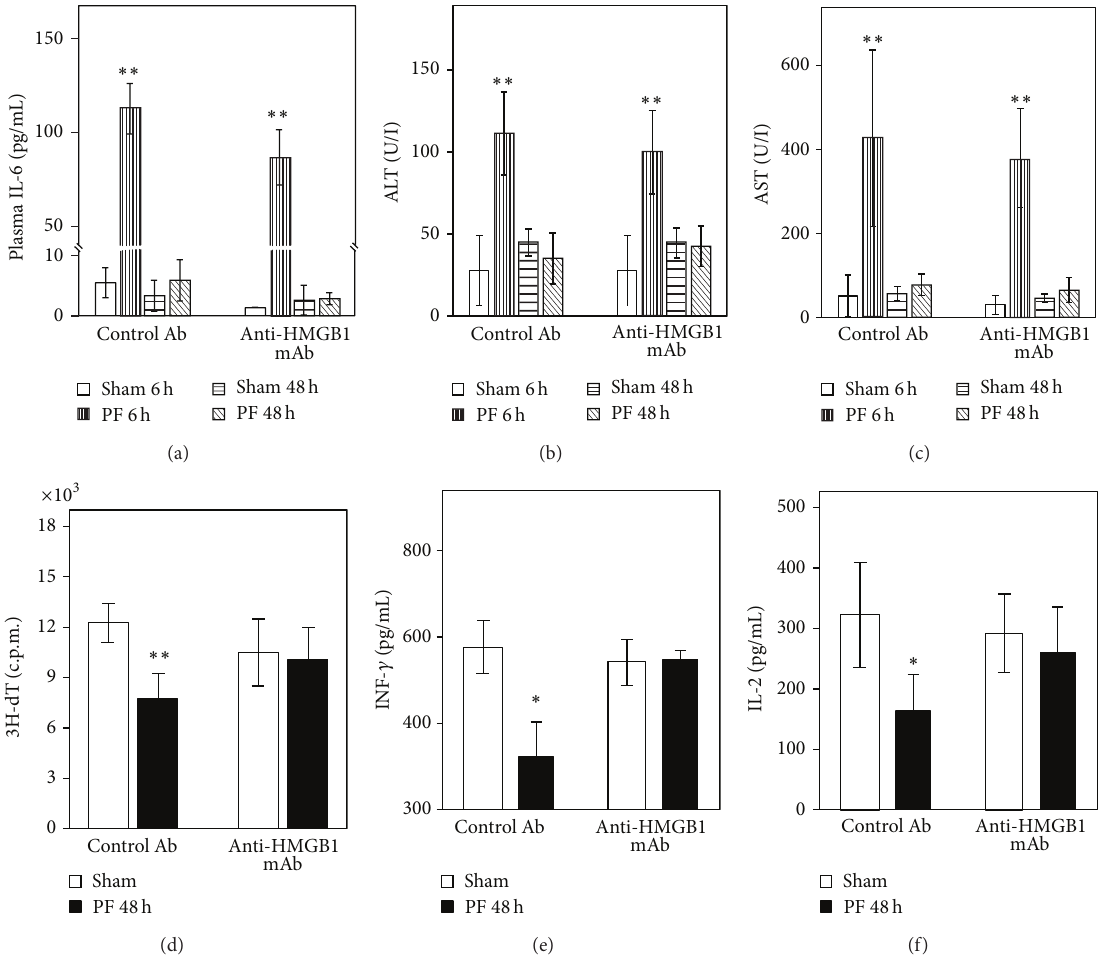
Figure3:Anti-HMGB1neutralizingmAbamelioratesattenuatedT-cellresponsesatlatetimepoints,butnottheearlyinflammatoryresponses or hepatic injury after pseudofracture (PF). Plasma IL-6 (a), ALT (b), and AST (c) at 6h and 48 h after PF in control and HMGB1 Ab-treated mice. Splenocytes were isolated for T-cell proliferation in response to con A (d) and Th1/2 cytokines production ((e), (f)) at 48 h after PF. ∗ 𝑃 < 0.05 ; ∗∗ 𝑃 < 0.01 versus corresponding uninjured control group. Data represent means ± SEM; 𝑛 = 6–8 mice per